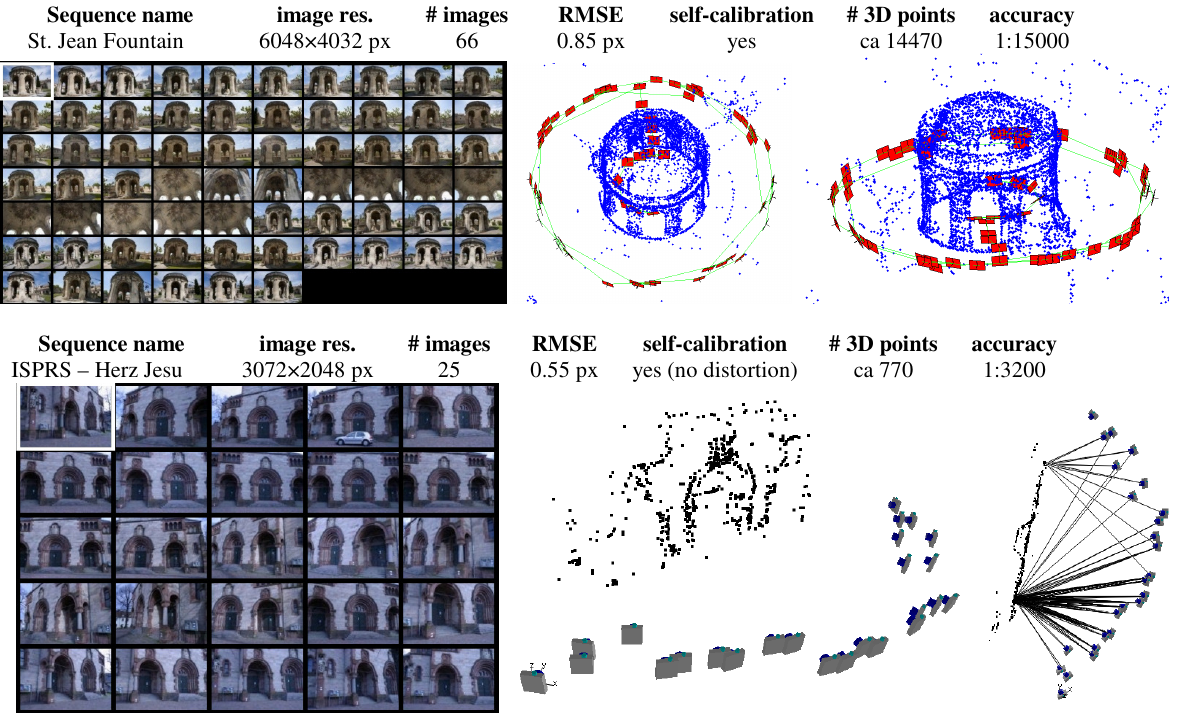
Figure 3: Examples of unordered image sequences.